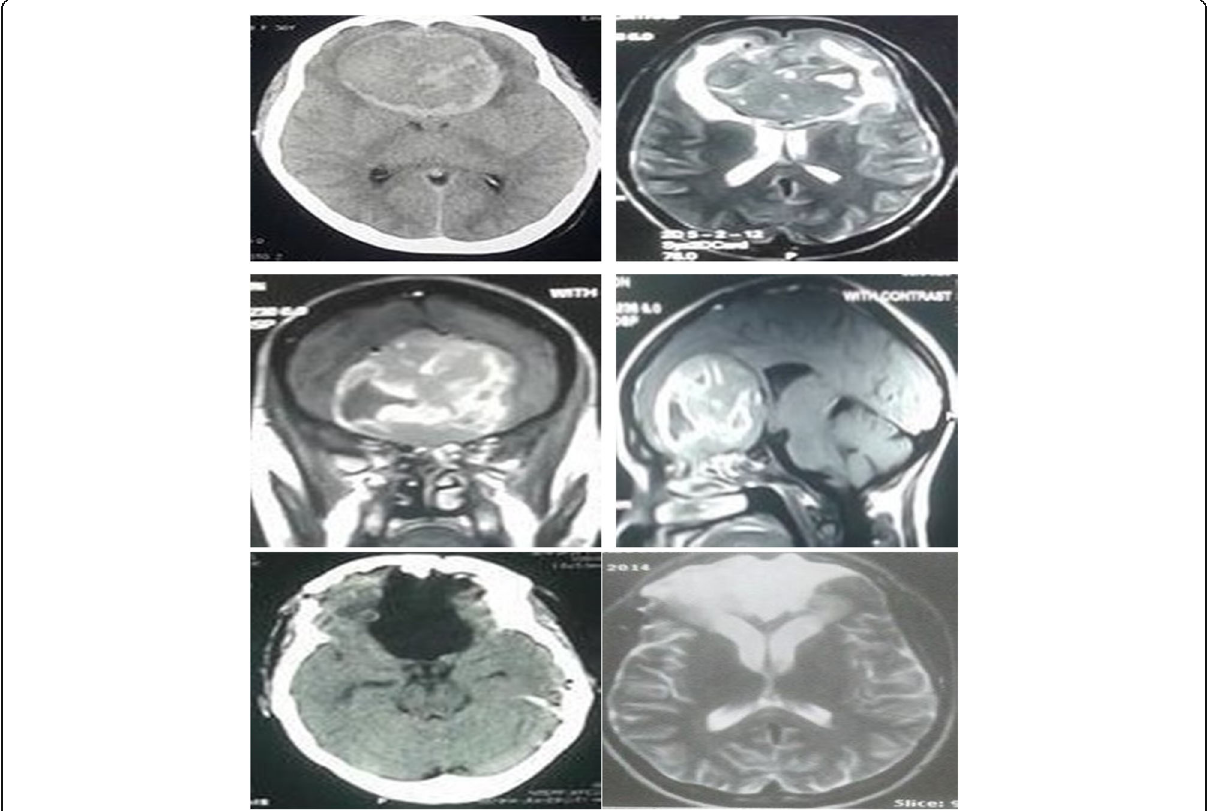
Fig. 1 Giant olfactory groove meningioma. Upper left, axial CT brain with contrast. Upper right, axial MRI TII of the same lesion with cystic components inside lesion. Middle left, coronal MRI with contrast showing heterogeneous enhancement. Middle right, sagittal MRI with contrast with heterogeneous enhancement. Lower left, postoperative CT 1 month later with bifrontal craniotomy and large cerebrospinal fluid (CSF) space in place of tumor removal after total removal. Lower right, MRI TII axial cut of the same case done 1 year after surgery with total removal and no